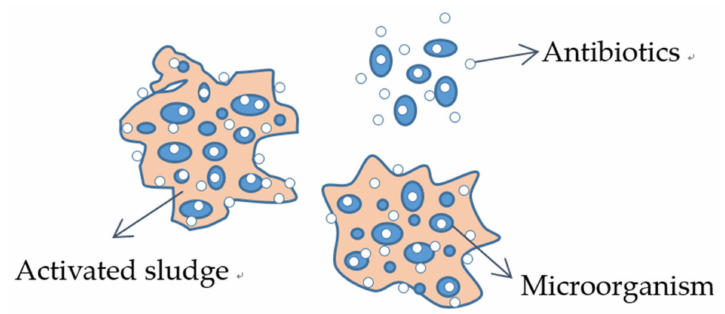
Figure 2. The main mechanism of action of antibiotic biological